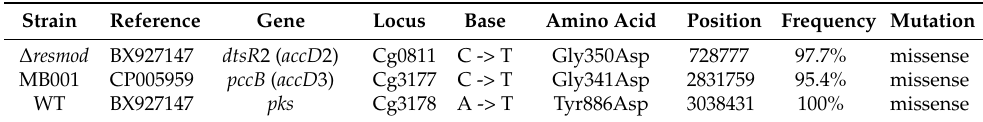
Table 2. SNP analysis using the bioinformatic tool Snippy [48] was used to discover mutations in different C. glutamicum strains showing resistance towards CL31